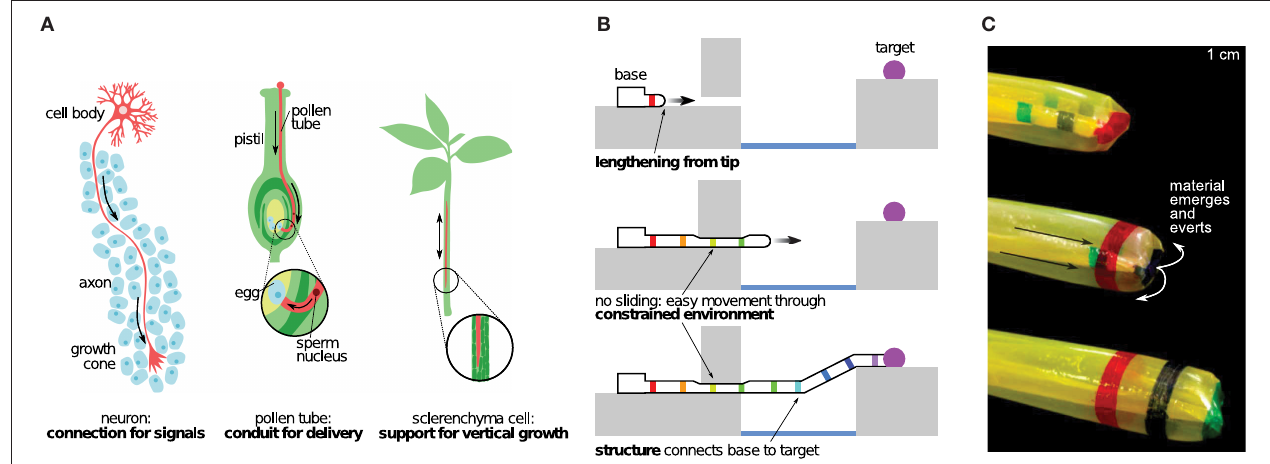
FIGURE 1 | The biological inspiration for and basic properties of tip growth, and our implementation of artificial growth via eversion. (A) Examples of biological systems that grow to navigate their environments. (B) Schematic representing growth by tip-extension. (C) Artificial growth created by pressure-driven eversion of a flexible, thin-walled tube. Modified from Hawkes et al. (2017). Reprinted with permission from